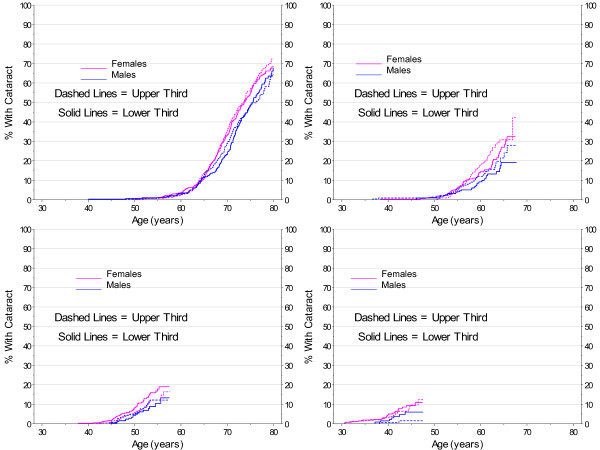
Kaplan-Meier Estimates for Cataract by Gender and Antioxidants (lower vs. upper third) Cohort with No Diabetes.